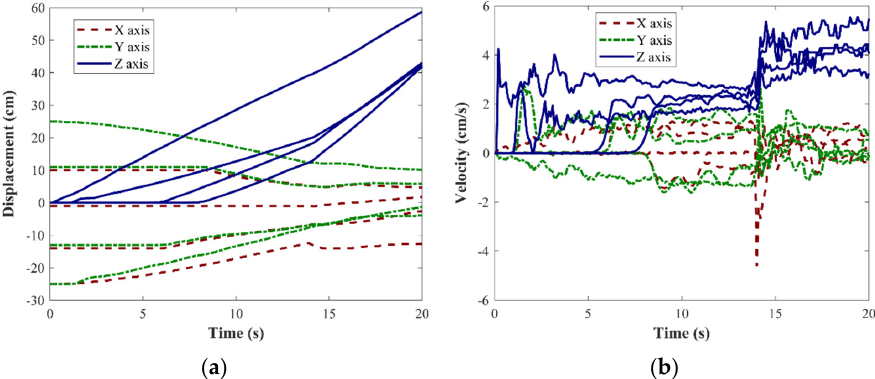
Figure 9. Position and velocity variations of four stochastic net nodes. ( a ) Position variations of four stochastic net nodes. ( b ) Velocity variations of four stochastic net nodes.